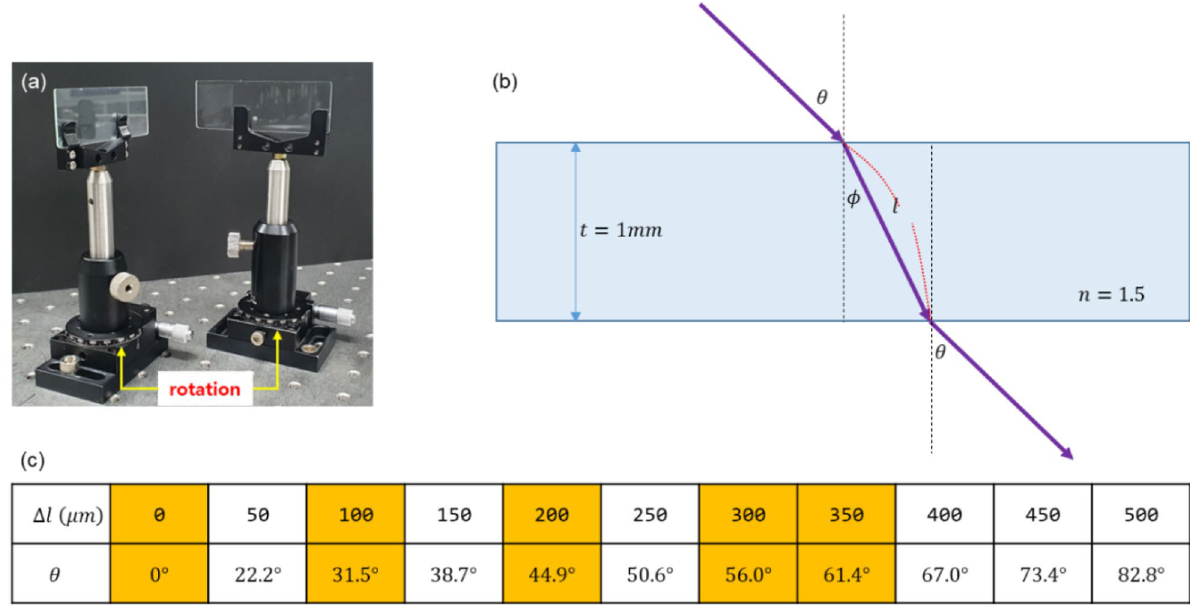
Figure 3. MZI path length control. ( a ) Samples of the glass plate pair inserted in the MZI paths of Fig. 1. ( b ) A cross section of the glass plate and rotation angle θ with respect to the normal direction. ( c ) The rotation angle related lengths.